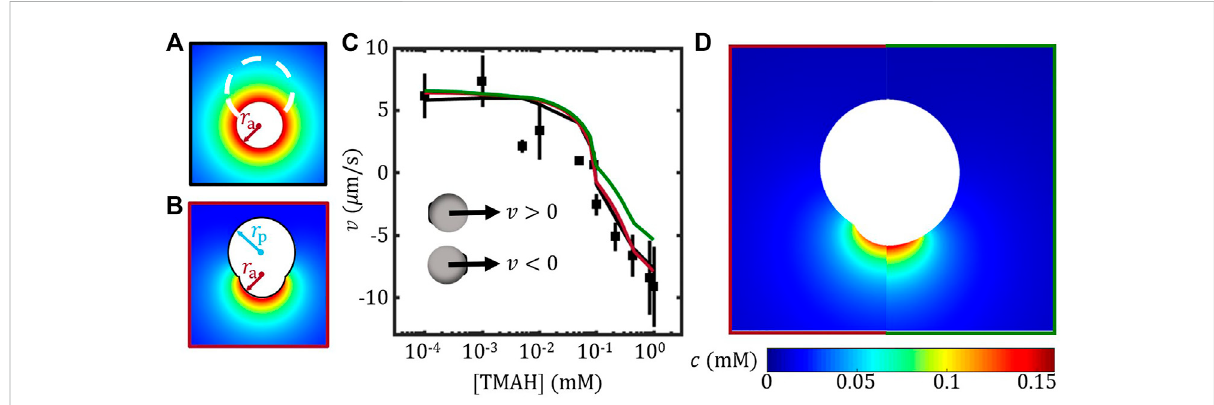
FIGURE 2 FEMstudyoftheself-propulsion velocityofTPM/haematiteJanus colloids. (A) Illustrationofthefar- fi eldapproximation (B) Construction ofthe geometric model for the Janus colloids. (C) Velocity of Janus colloids vs. [TMAH]. FEM results considering the shape effect of the Janus (red) and a sphericalJanus(green)arepresentedtogetherwiththeexperimentalresults(datapoints)andfar- fi eldapproximation(blackline)re-plottedfromRef. Zhouetal.(2021).Theinsetsillustratethede fi nitionofvelocitydirection. (D) Comparingtheconcentration fi eldfromFEMbetweenmodelswith (left) and without (right) considering the shape of the Janus